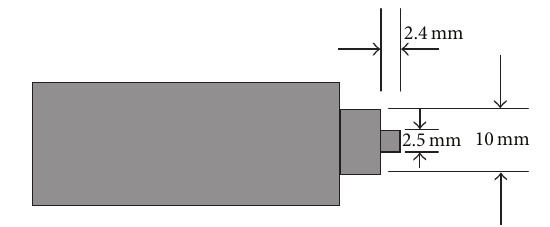
Figure 4: The tool shoulder and pin configuration diagram